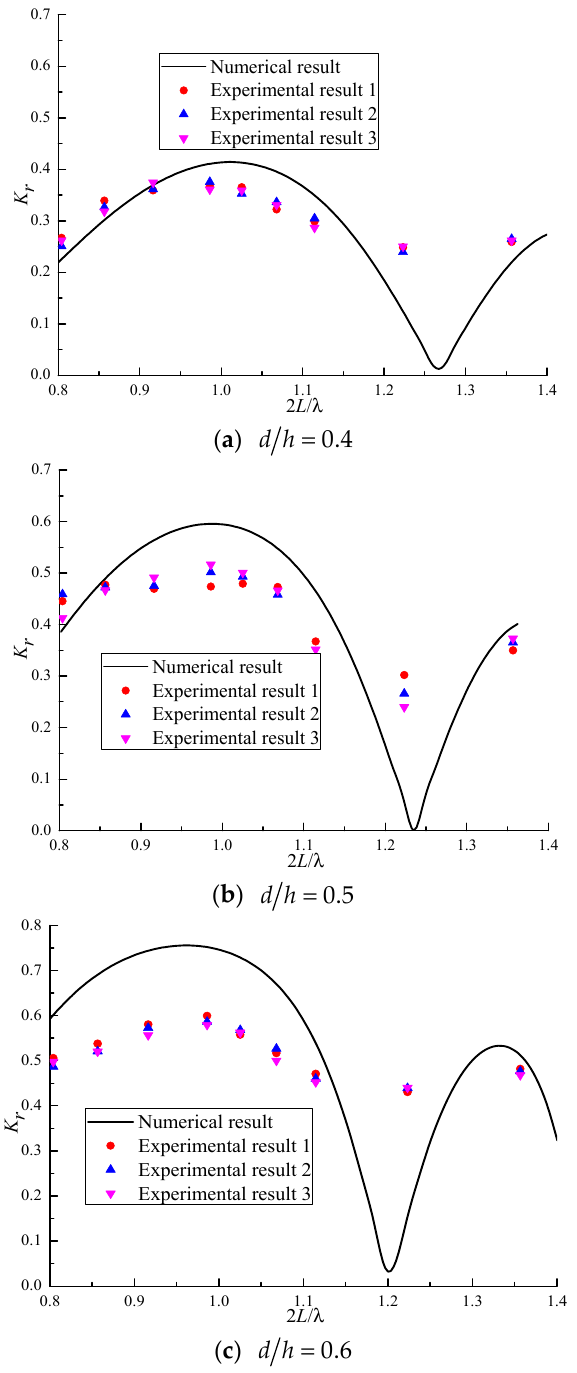
Figure 13. Comparisons of the numerical and experimental reflection coefficients ( N = 3 and 4.0 L h = ).